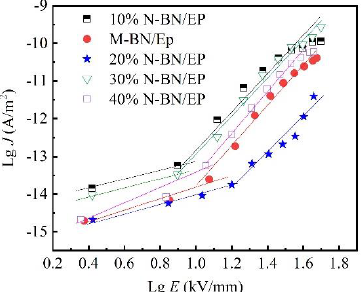
Figure 6. Current densities of sandwich-structured nanocomposites depended on electrical strength at different temperature.